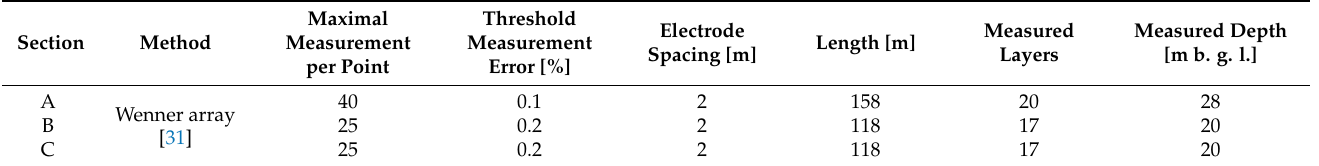
Table 4. Methodology and measurement configuration of electrical resistivity tomography (ERT) for Sections A, B and